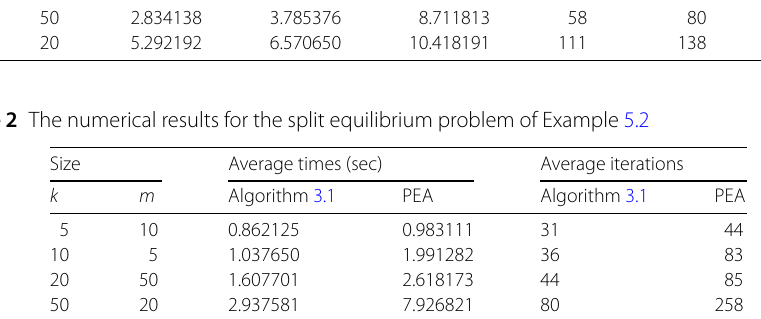
Table 1 The numerical results for different parameter β n of Example 5.1 Size Average times (sec) Average iterations k m Case 1 Case 2 Case 3 Case 1